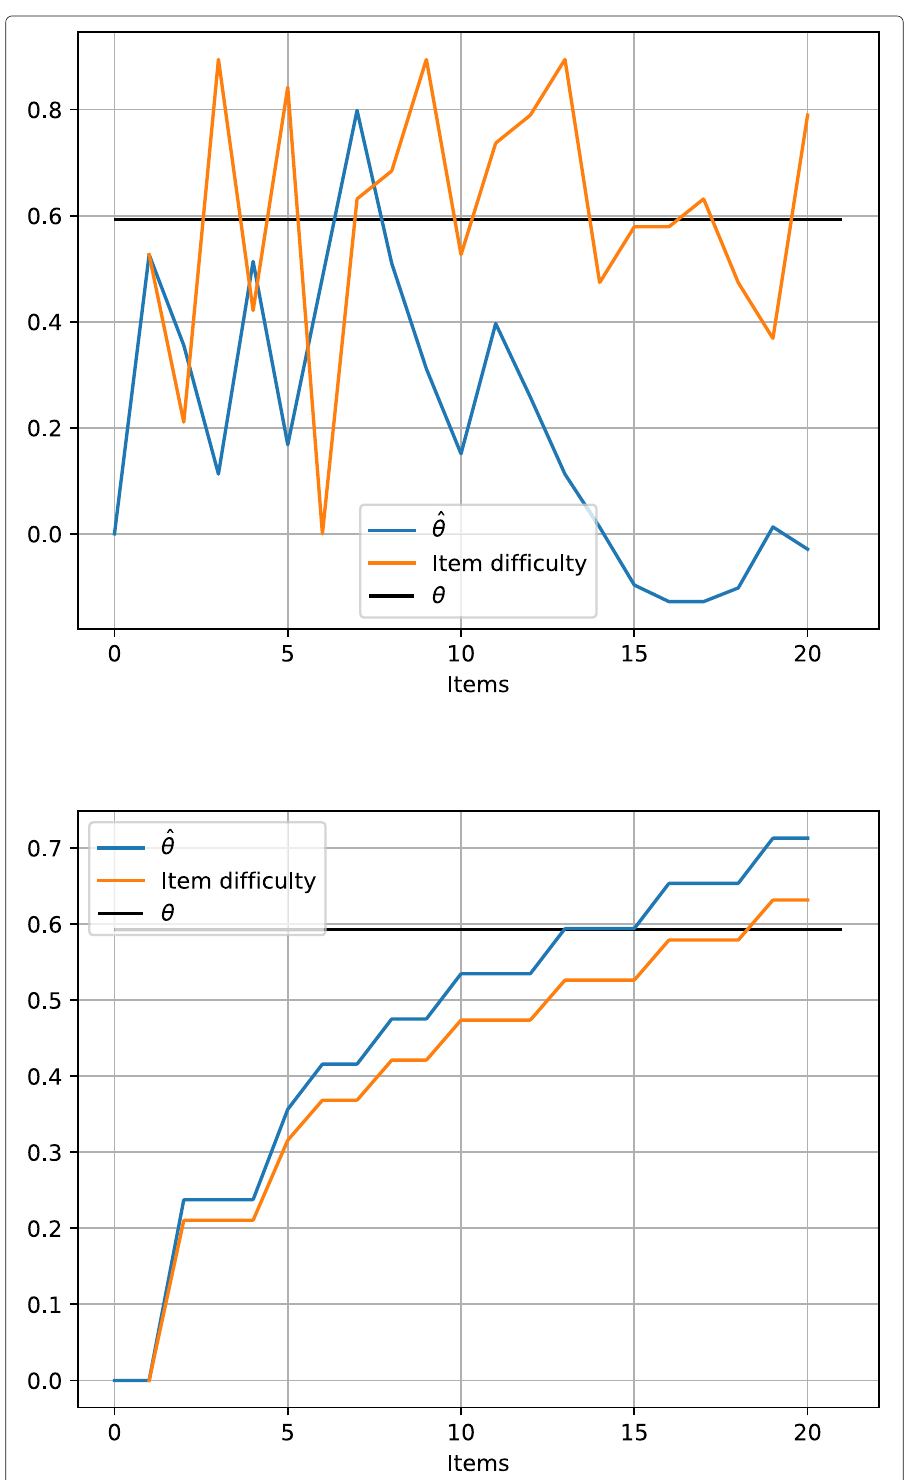
Fig. 6 Test progress of a test taker (top: LIN_EST simulation, the baseline; bottom: CAT_EST simulation, the gold